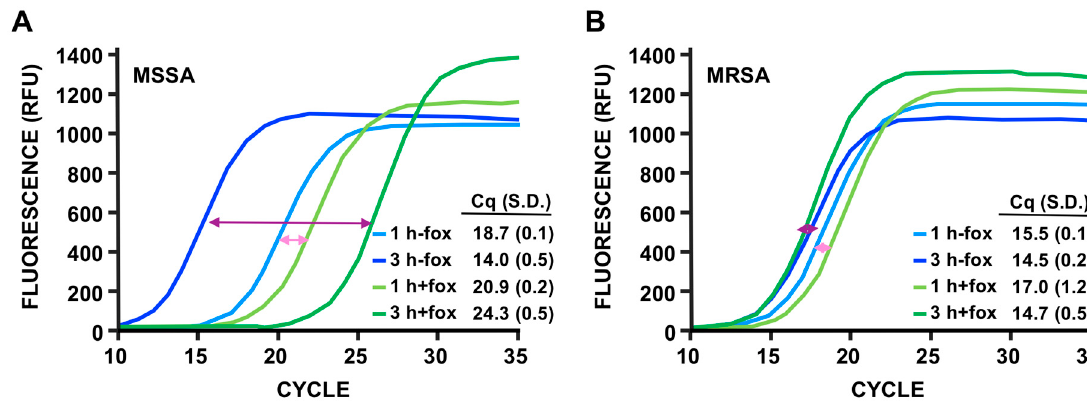
Figure 5. Discrimination of methicillin-sensitive SA (MSSA) versus methicillin-resistant SA (MRSA). ( A ) Fluorescent qPCR results of PMMD of the MSSA strain RN4220. The cultures were incubated with or without cefoxitin (fox) for 1 or 3 hours, as indicated. Representation of the results as in Figure 3C. Uninfected cultures, purified phage K and water controls did not produce signal. ( B ) Fluorescent qPCR results of PMMD of the MRSA strain SA1012.COI. The cultures were incubated with or without fox for 1 or 3 hours as indicated. The colored lines’ correspondence, relative fluorescent units (RFU), number of cycles and Cq average, and S.D. values of three biological replicates performed in parallel are shown. The double-headed arrows were added to better identify the curves comparing conditions with and without fox after 1 hour (light pink) and 3 hours (dark pink). Uninfected cultures, purified phage K, and water controls did not produce signal.